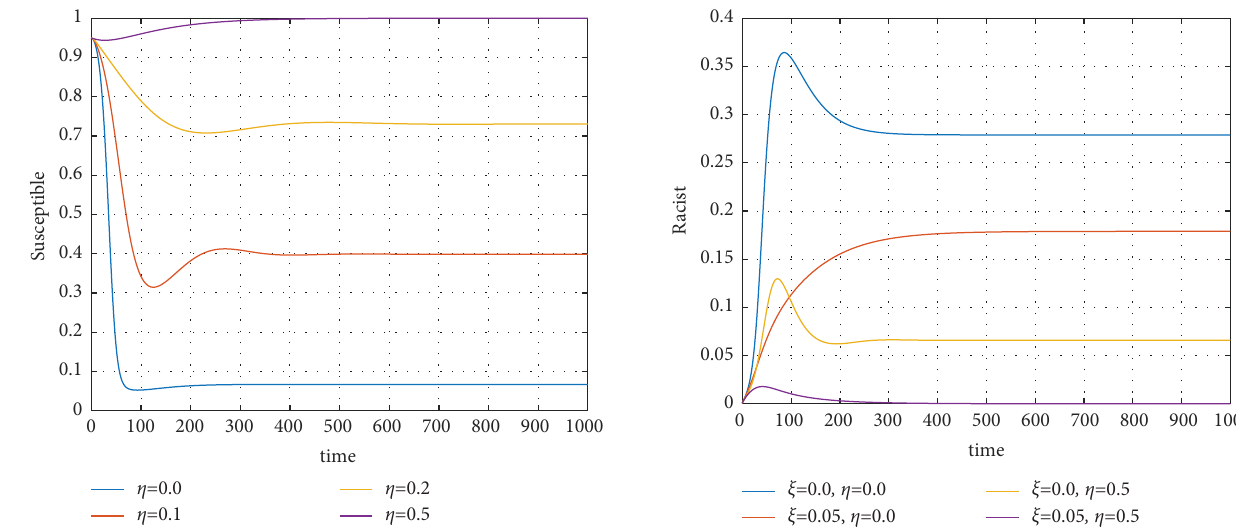
Figure 12: Te impact of η on susceptible. Figure 14: Te combine impacts of η & ξ on racist